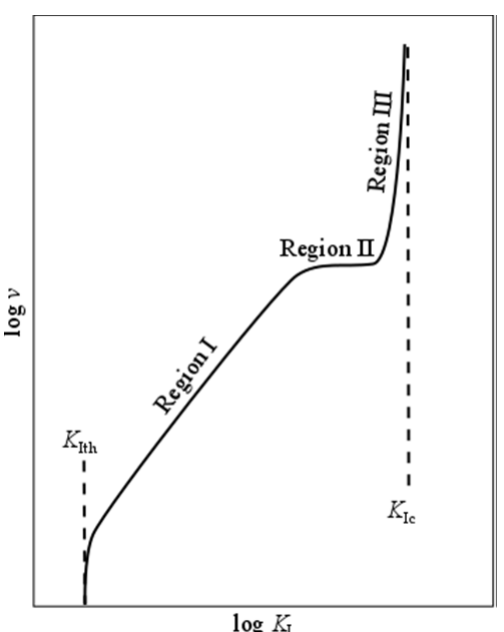
Fig. 2 Principal relationship between the crack growth velocity (cid:1874) and the Mode I stress intensity factor (cid:1837) (cid:2893) . Image adopted from Munz and Fett